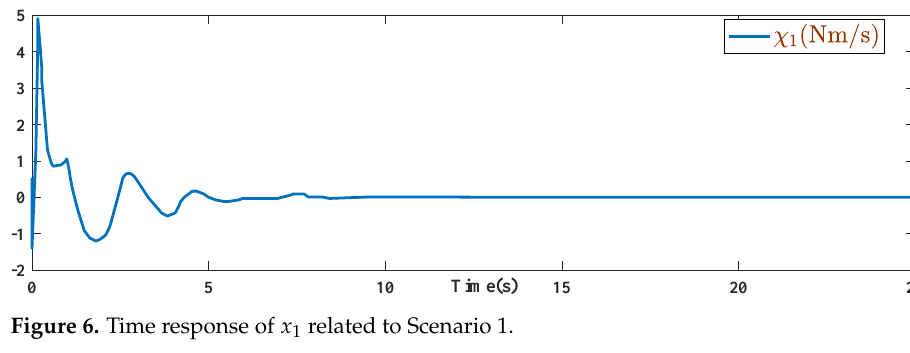
Figure 5. Time response of x v related to Scenario 1.